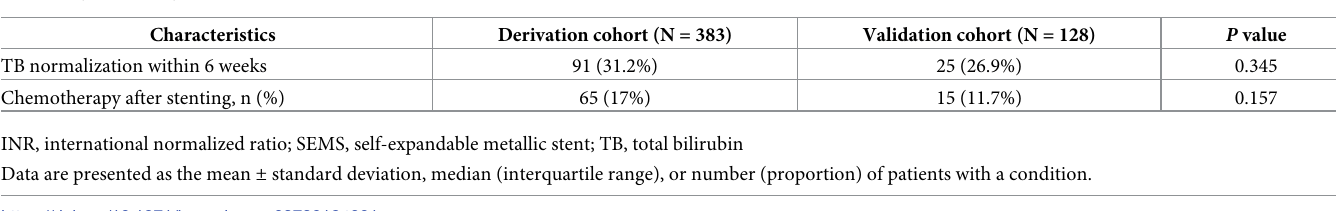
Table 2. Univariate and multivariate analyses of baseline variables for predicting 50% total bilirubin reduction within 2 weeks after stenting in the derivation cohort.